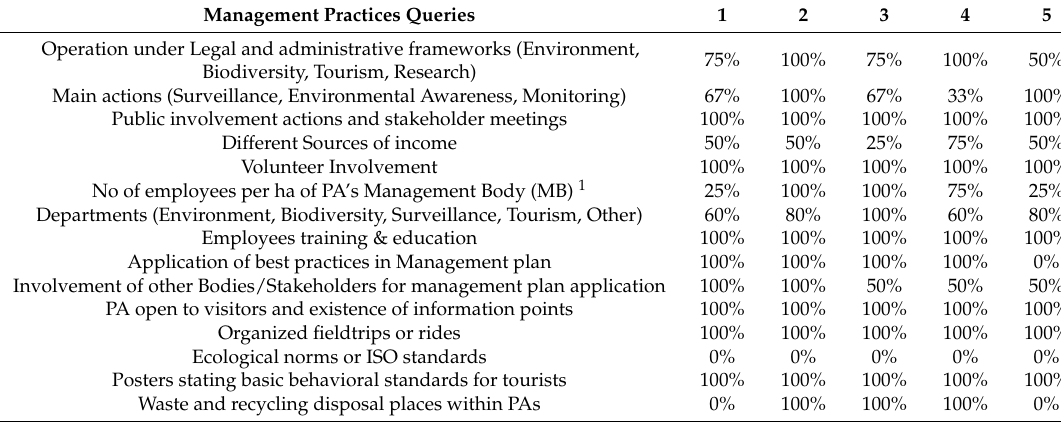
Table 1. Percentages of gap analysis of the five protected areas (PAs) regarding the management practices. 1: L’ Albufera, 2: Krka, 3: Mincio, 4: Una, 5: Karla.